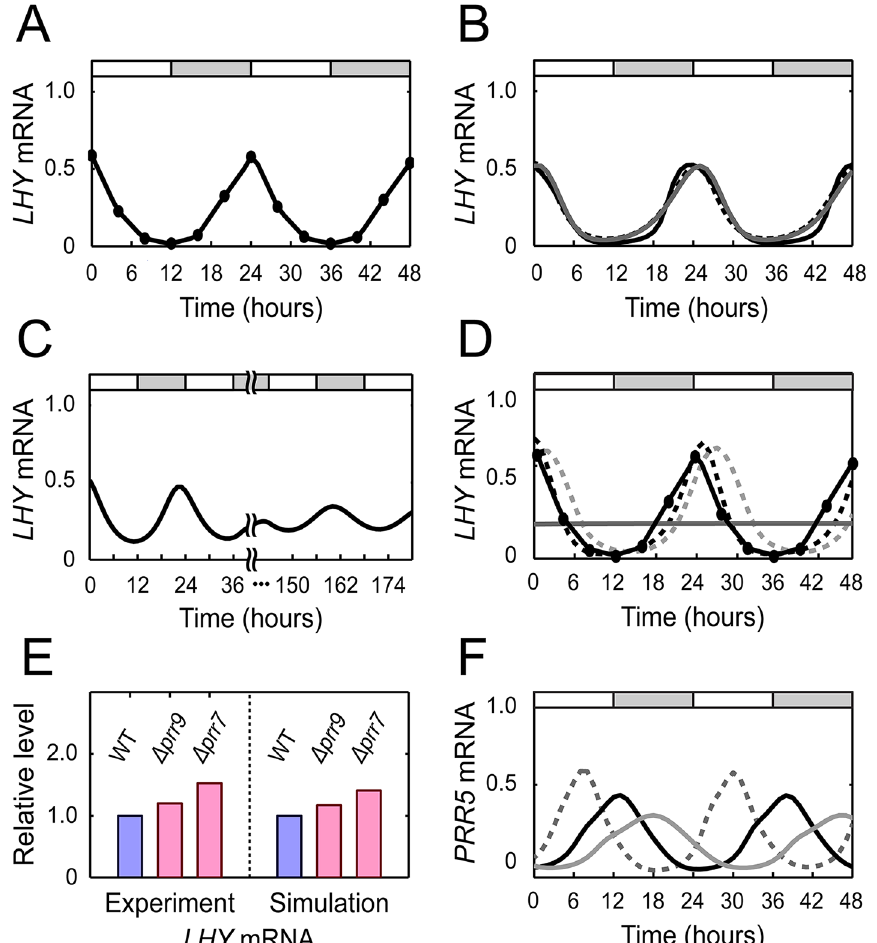
Fig 3. Dynamical properties of the kernel. (A) Experimental LHY mRNA levels in LL (S1 Table). (B, C) LHY mRNA levels from each simulation of loops I to III (B) and loop IV (C) in LL. The parameters of each loop were re-optimized for WT expression data in LL. Black solid, black dotted, and gray solid lines in (B) are for loops I, II, and III, respectively. (D) The same LHY mRNA levels in (A), along with simulated LHY mRNA levels when LHY/CCA1 inhibition by PRR5 (black dotted), or by PRR7 (gray dotted), or by both PRR5 and PRR7 (gray solid) was removed from MF2015. The MF2015 simulation was performed in LL with re-optimized parameters. (E) LHY mRNA levels from the Δ prr9 and Δ prr7 knockout mutants in LL (time averages normalized with respect to WT data). Experimental values [29] and MF2015 simulation results are compared. (F) MF2015-simulated PRR5 mRNA levels in LL when PRR5 inhibition by LHY/CCA1 is increased (gray solid) or decreased (gray dotted) by 20%, or is not adjusted (black solid). In (A – D, F), white and gray segments indicate subjective days and nights,